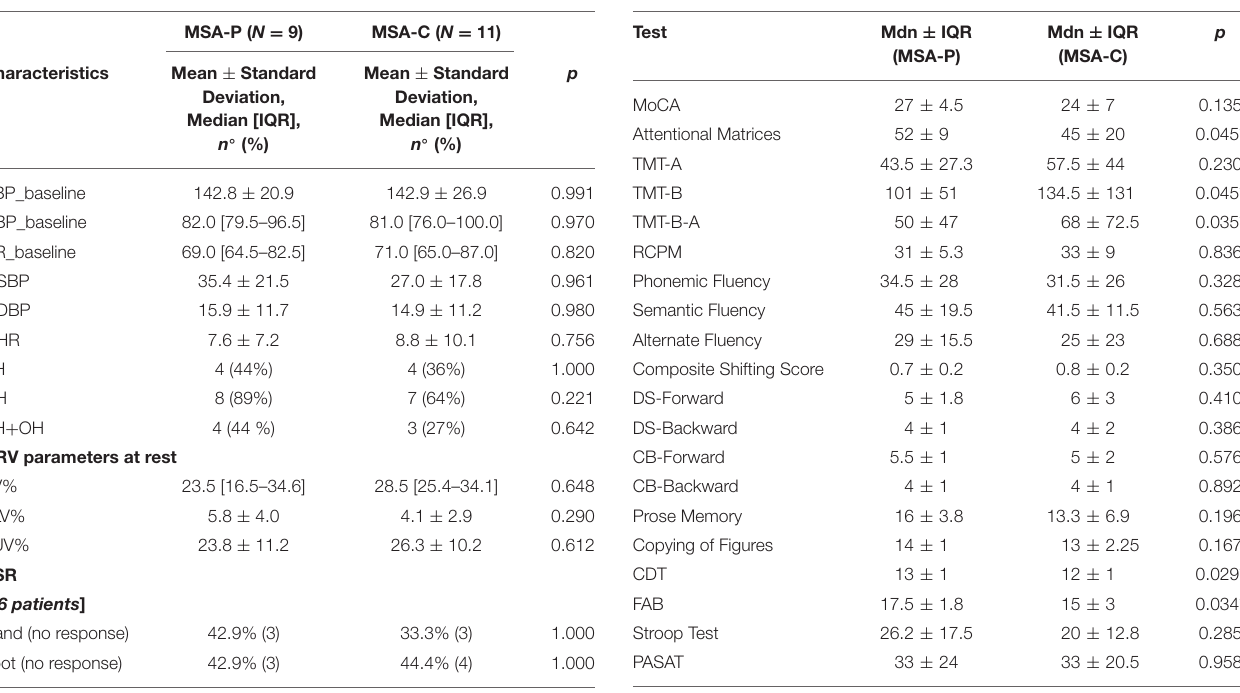
TABLE 3 | Cognitive performances of MSA-P and MSA-C patients at neuropsychological tests.